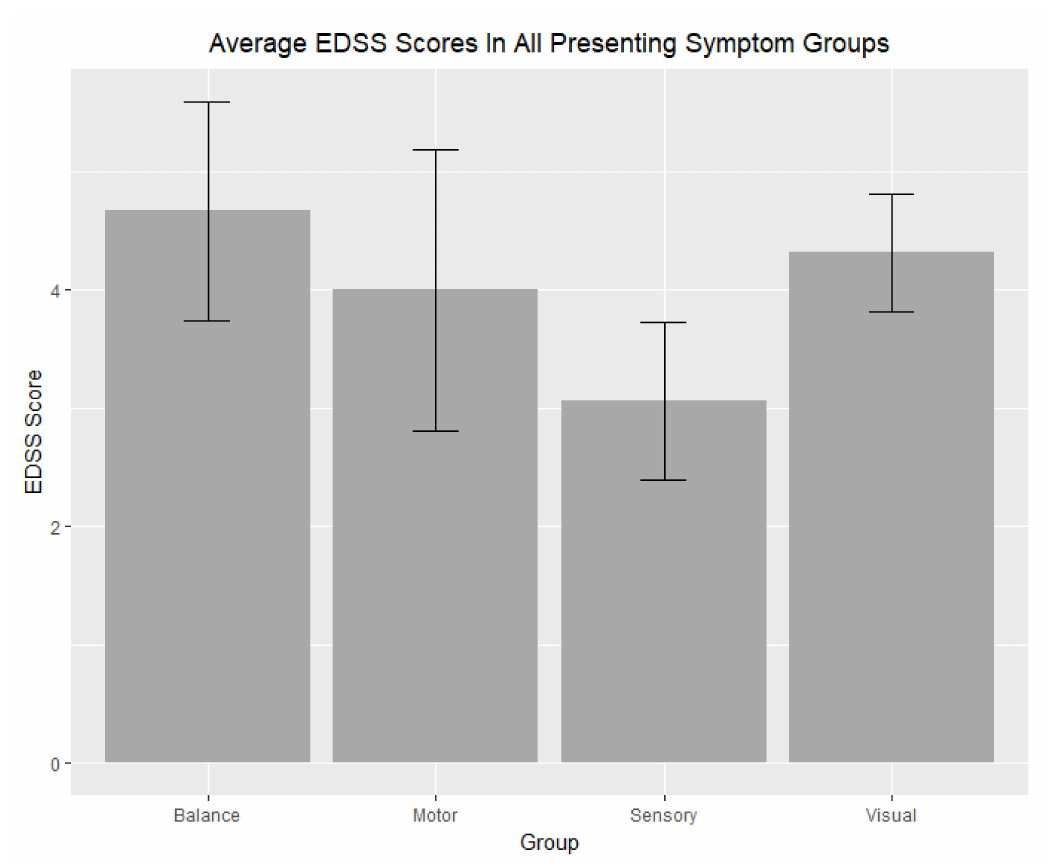
Figure 2. Average EDSS Scores In All Presenting Symptom Groups. The average EDSS scores in the Balance (4.66667), Visual (4.31818), Motor (4.0000), and Sensory (3.06250) groups were not significant different. Error bars represent the standard error of the mean in the Balance (0.92761), Visual (0.49668), Motor (1.19024), and Sensory (0.67107)